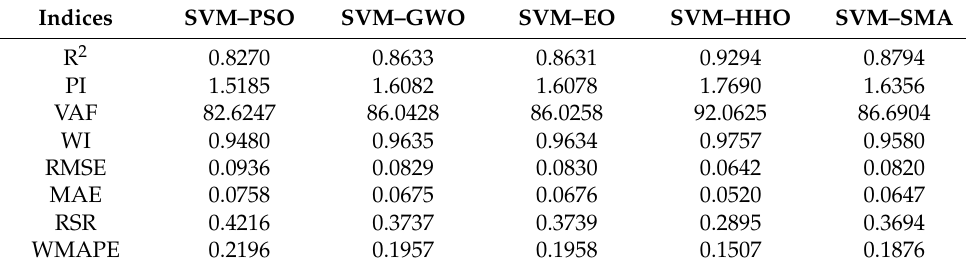
Table 7. Performance indices for the testing